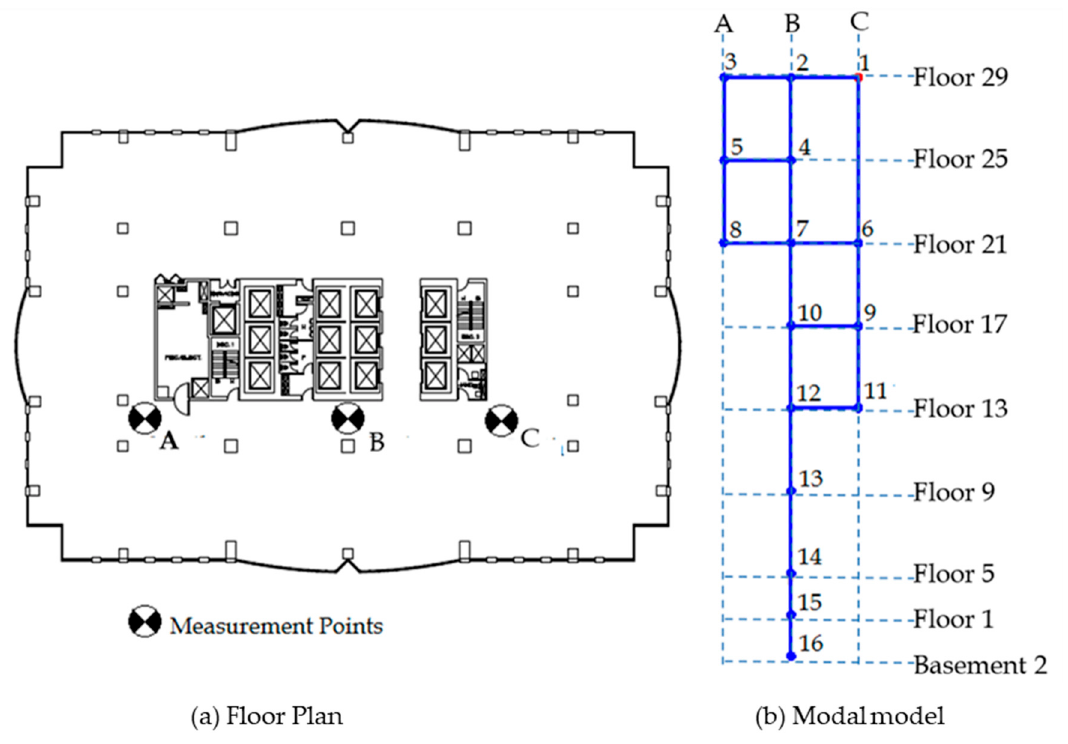
Figure 14. ( a ) Typical floor plan of the test building showing location of sensors and ( b ) modal model that resulted from the choice of measurement points.